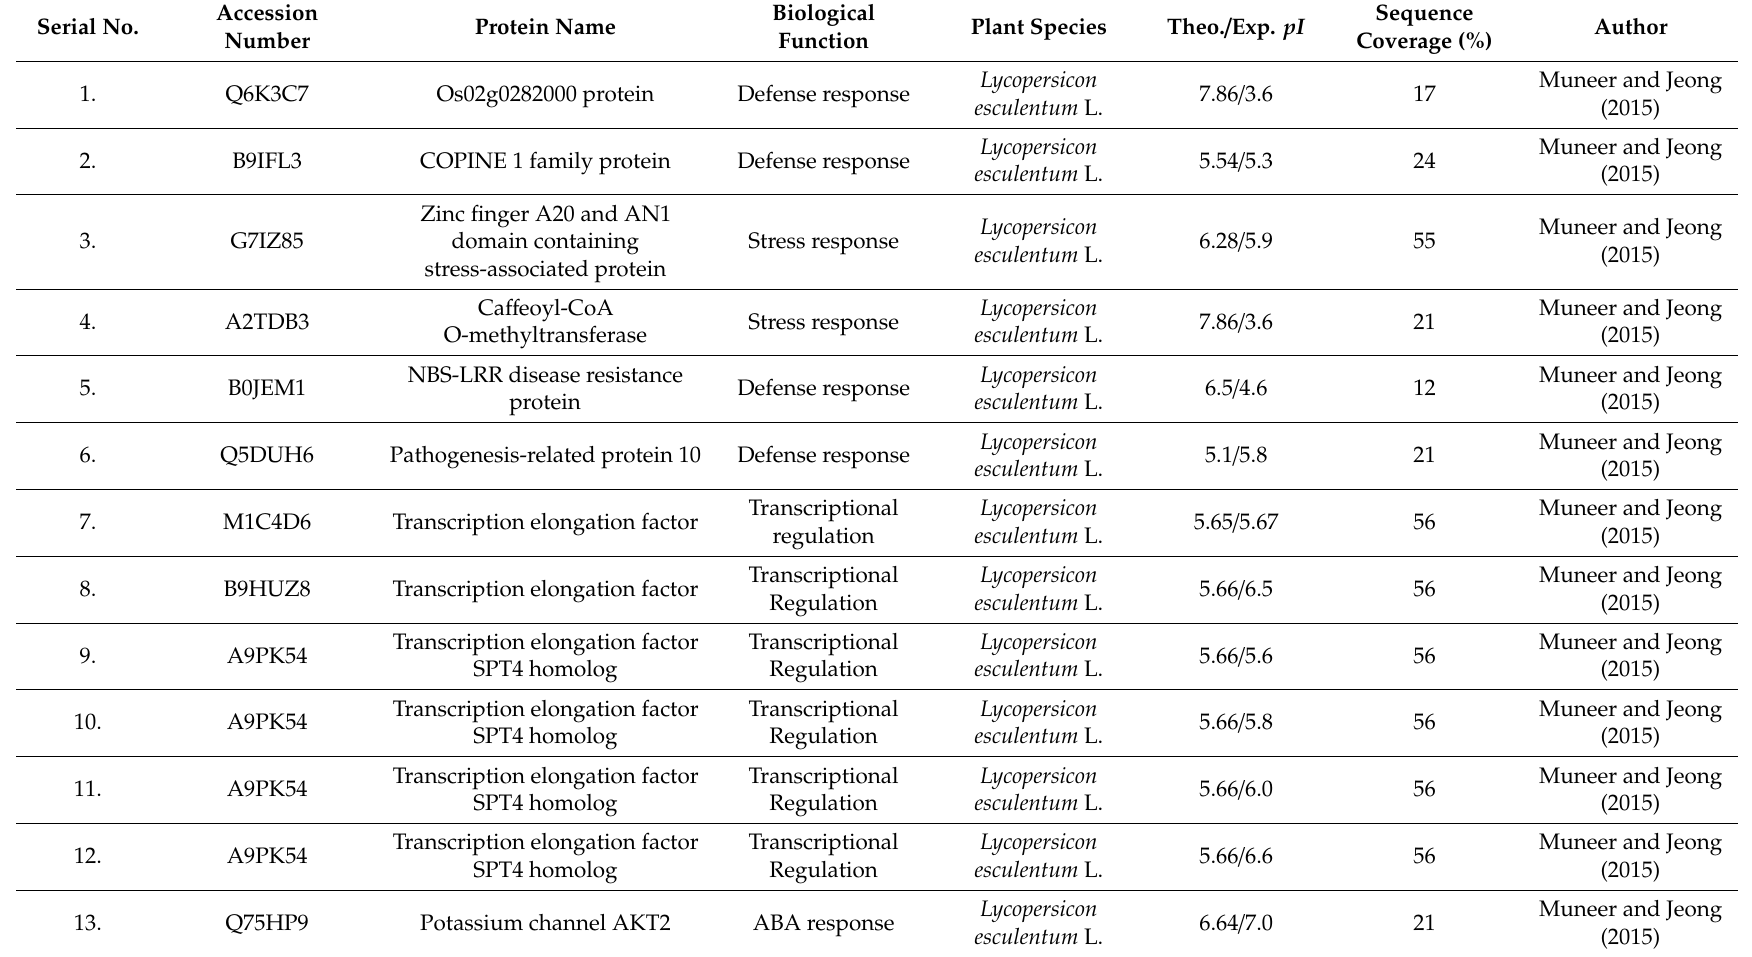
Table 1. List of proteins identified in horticultural crops under salinity stress under silicon supply. Serial